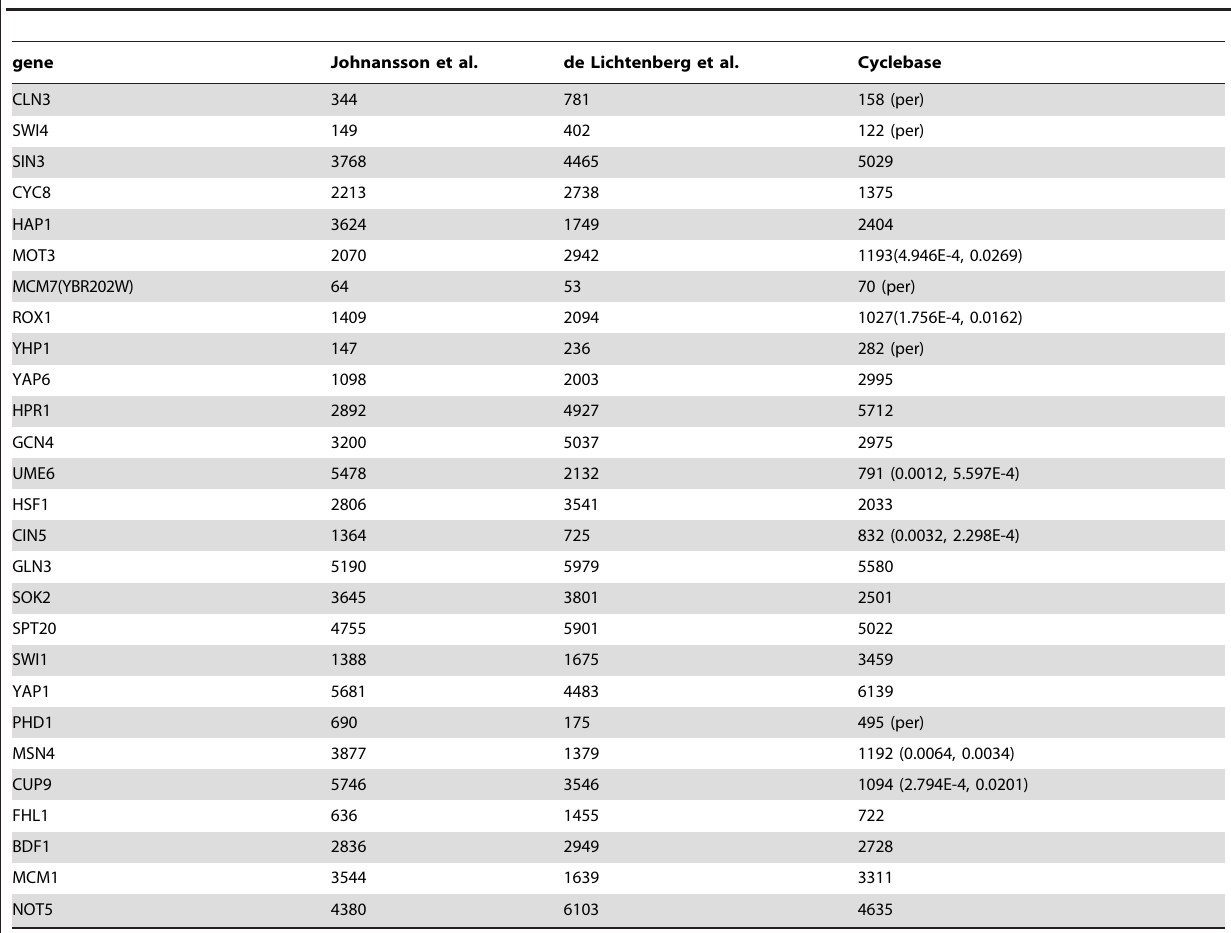
Table 3. All non-periodic genes in the